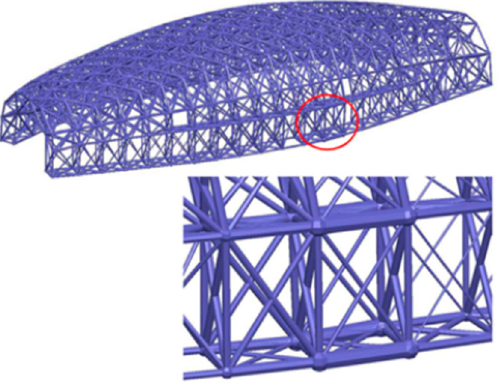
Figure 21. Non-uniform lattice structure based on SMS method [191].